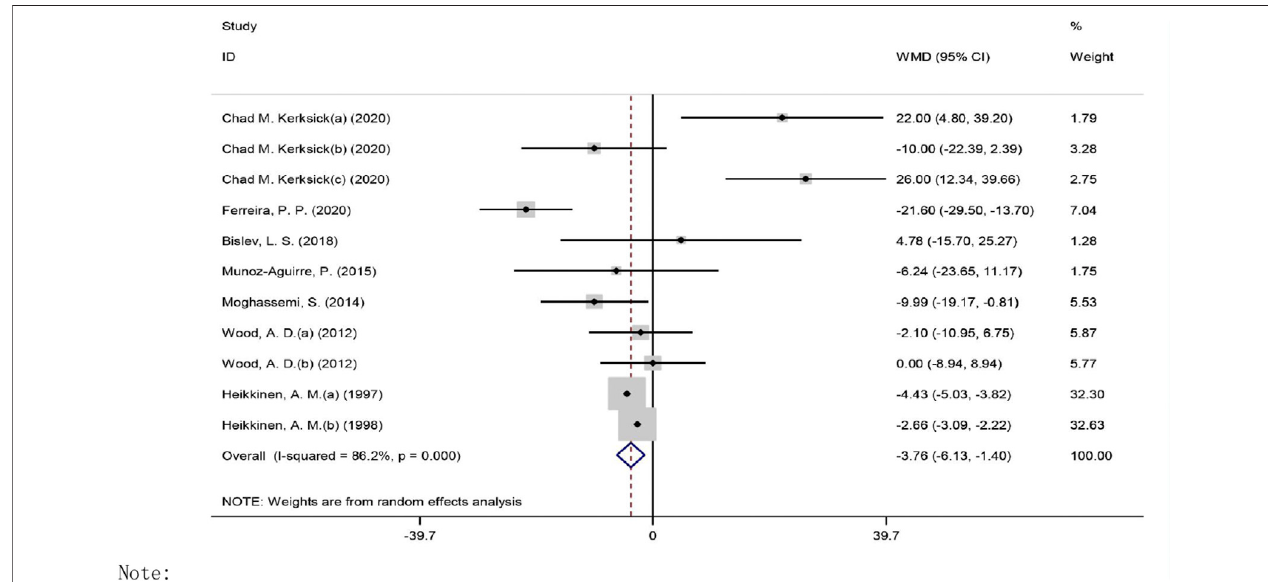
FIGURE 4 | Forest plot of the randomized controlled trials investigating the effects of vitamin D on TG.